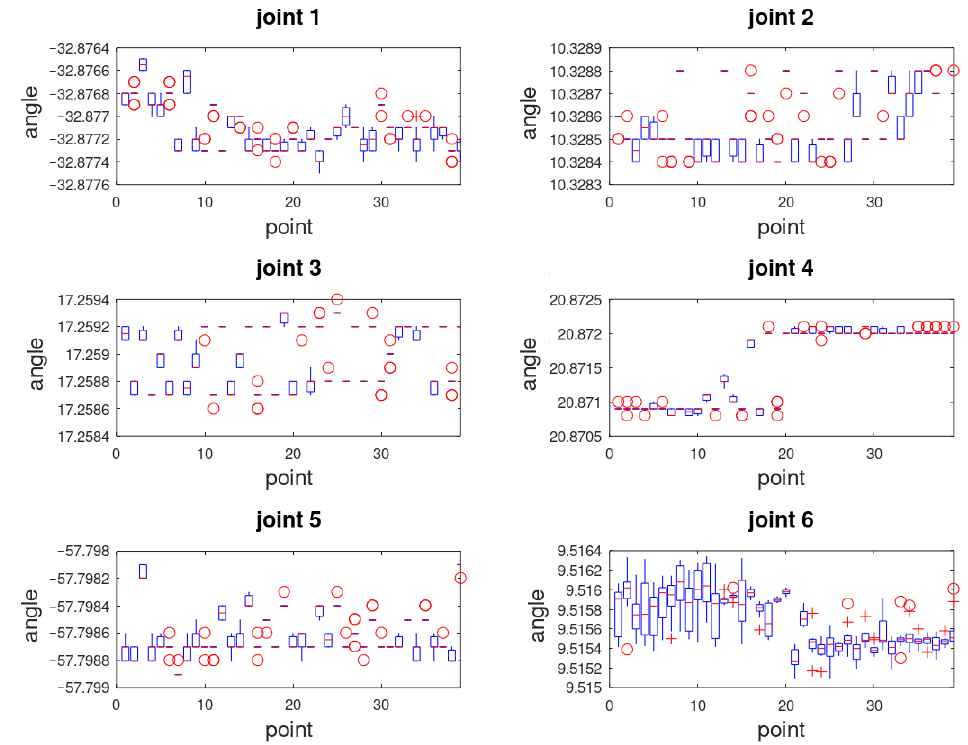
Figure 10. Error (°) distribution on individual robot joints during Measurement 16.